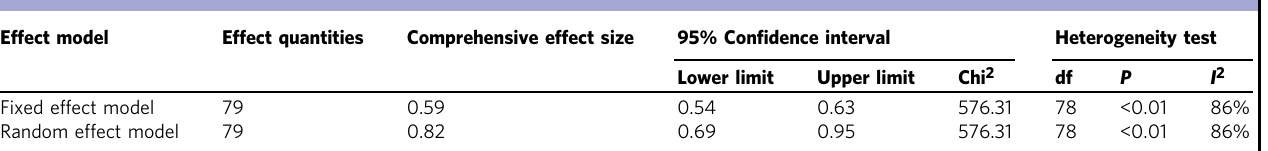
Table 2 Tests results for